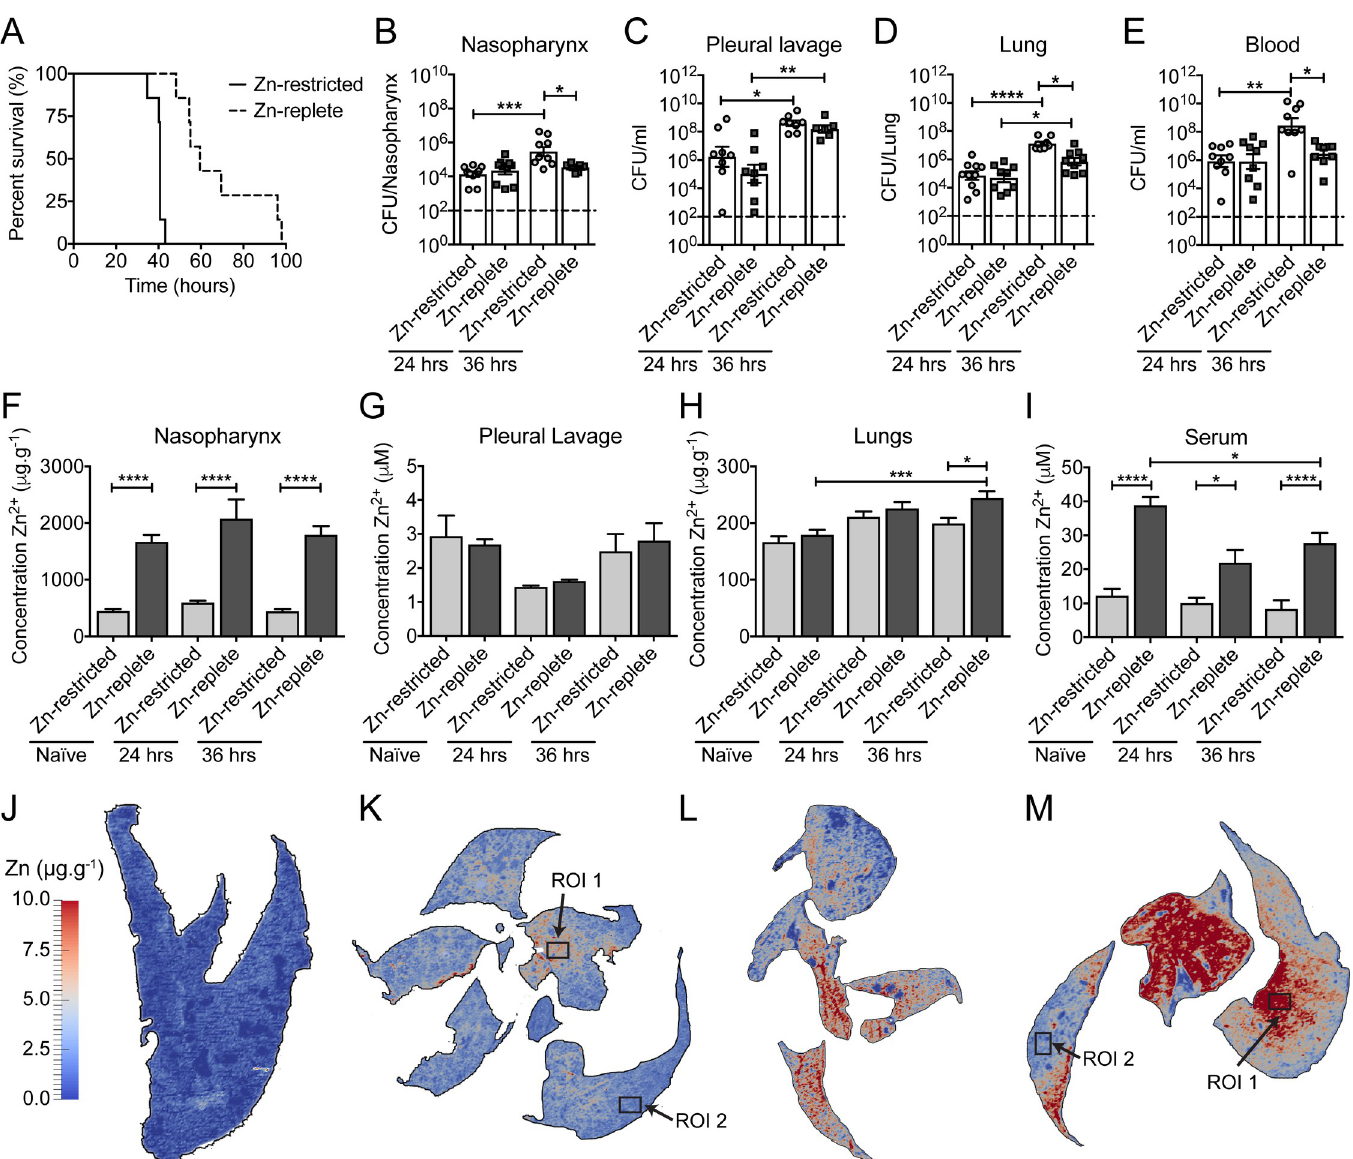
Fig 1. The effect of Zn restriction on animal survival, bacterial burden and tissue Zn abundance. (A) Survival of Zn-restricted or Zn-replete mice following intranasal challenge with 1 × 10 7 CFU of S . pneumoniae strain D39. Data represent analyses of seven mice with statistical analyses performed using a Log-rank (Mantel-Cox) test. Enumeration of S . pneumoniae from host niches, nasopharynx (B), pleural lavage (C), lung (D), blood (E), following intranasal challenge with 1 × 10 7 CFU of strain D39 (n � 7). Colonisation was examined at 24 and 36 hrs post challenge in Zn-restricted or Zn-replete mice. Data represent the mean ( ± S.E.M.) of four independent experiments with statistical analyses performed by a one-way ANOVA. Determination of murine niche Zn abundance, nasopharynx (F), pleural lavage (G), lung (H), blood serum (I), prior to infection, or 24 hrs or 36 hrs post infection in both dietary groups (n � 5) by ICP-MS. Data represent the mean ( ± S.E.M.) of four independent experiments with statistical analyses performed by a one-way ANOVA. Spatial distribution of Zn in the lungs of na ï ve Zn-restricted (J), or infected Zn-restricted (K) mice, and na ï ve Zn-replete (L) or infected Zn-replete (M) mice at 36 hrs post challenge. These data are representative elemental maps of murine tissue sections from analyses of at least three distinct murine samples (n � 3) by laser-ablation-ICP-MS with quantitated regions of interest (ROI) highlighted. Mean ( ± S.E.M.) elemental data for the distinct tissue sections is presented in S2 Table. The scale bar represents a heat map (blue to red) for the intensity of Zn from 0 to 10.0 μ g.g -1 .